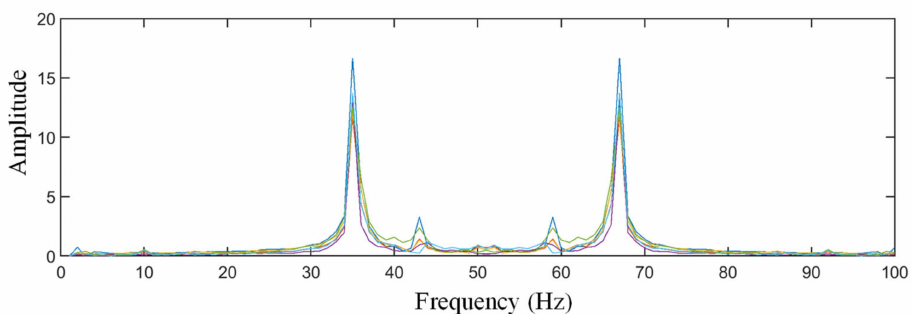
Figure 17. The spectrum curves of the different structural